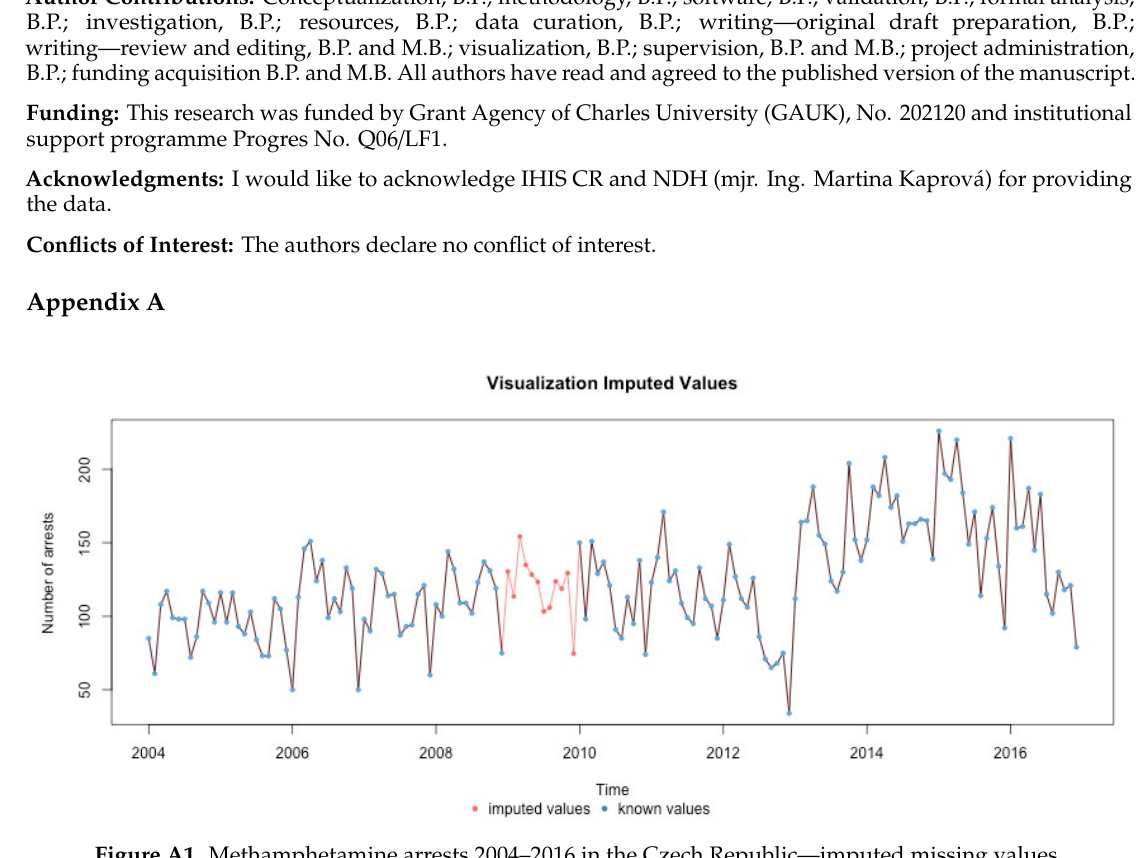
Figure A1. Methamphetamine arrests 2004–2016 in the Czech Republic – imputed missing values.